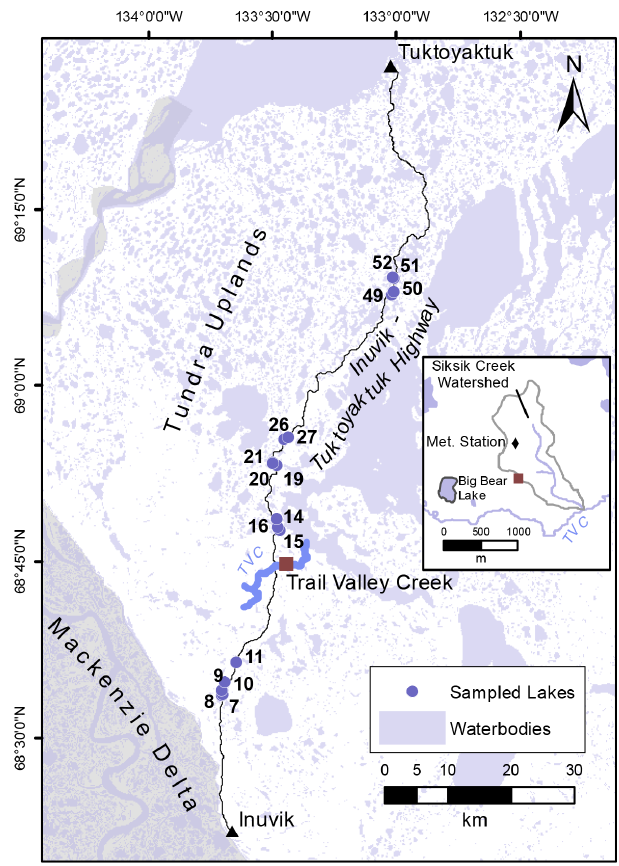
Figure 2. Blue circles indicate lakes that were sampled before and after snowmelt in 2018. Tundra uplands are in white, while the Mackenzie Delta is in grey. In the inset, key locations near the Trail Valley Creek field station are shown.